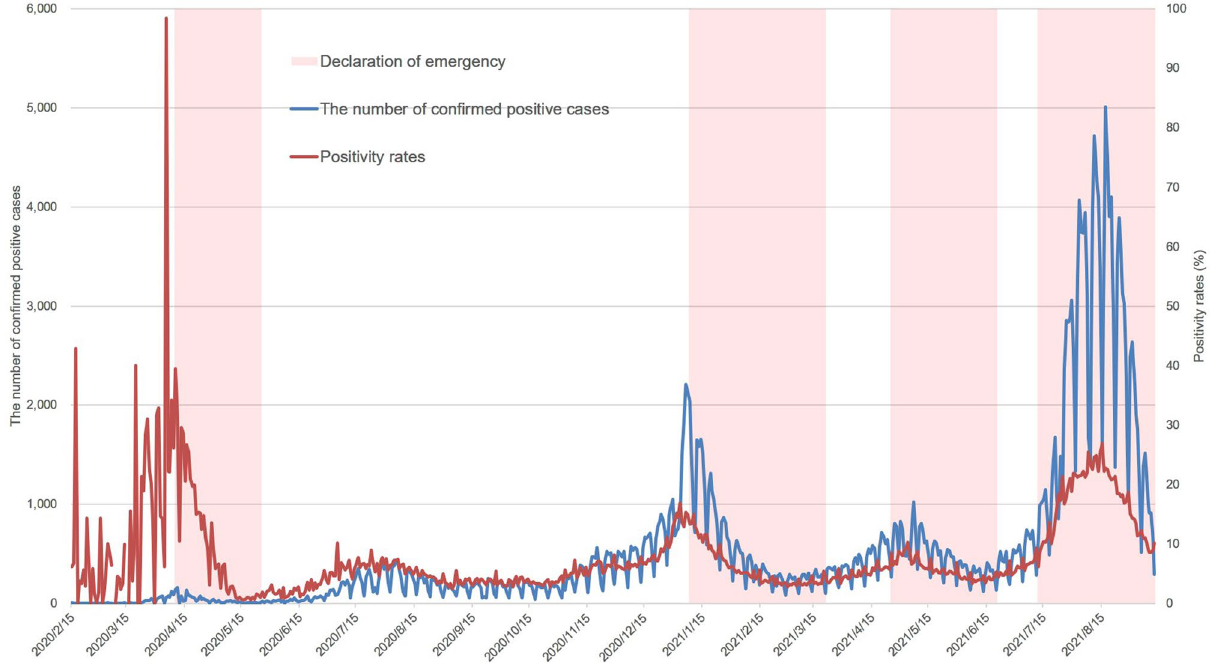
Figure 1. Time series transition of the number of confirmed positive cases and positivity rates and the period of emergency declaration in Tokyo. The daily number of confirmed positive cases (blue line) and positivity rates (red line) are shown. The periods of the emergency declaration are shown in